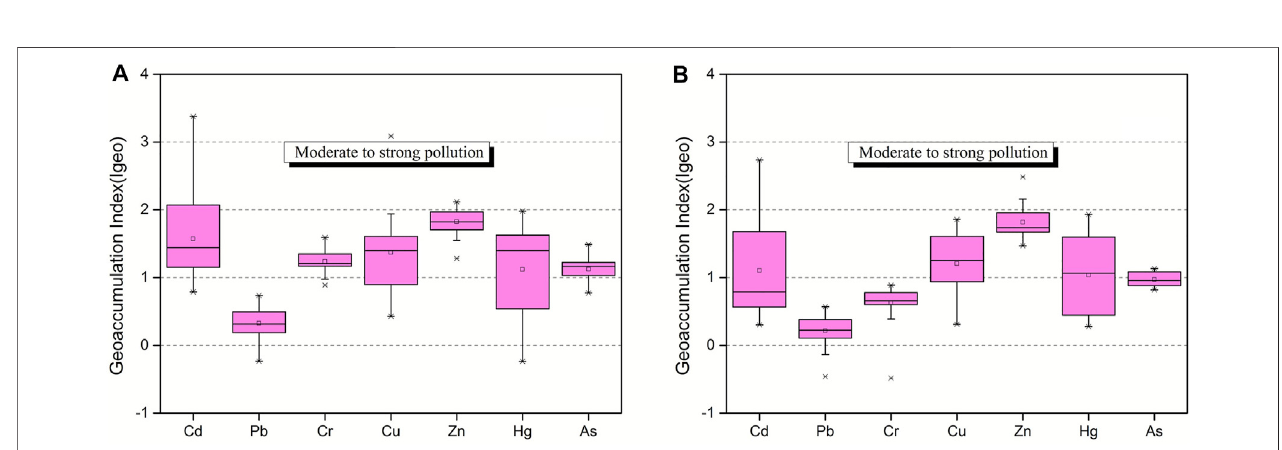
FIGURE 5 | Geoaccumulation index ( I geo ) of heavy metals in surface sediments during spring (A) and autumn (B) .